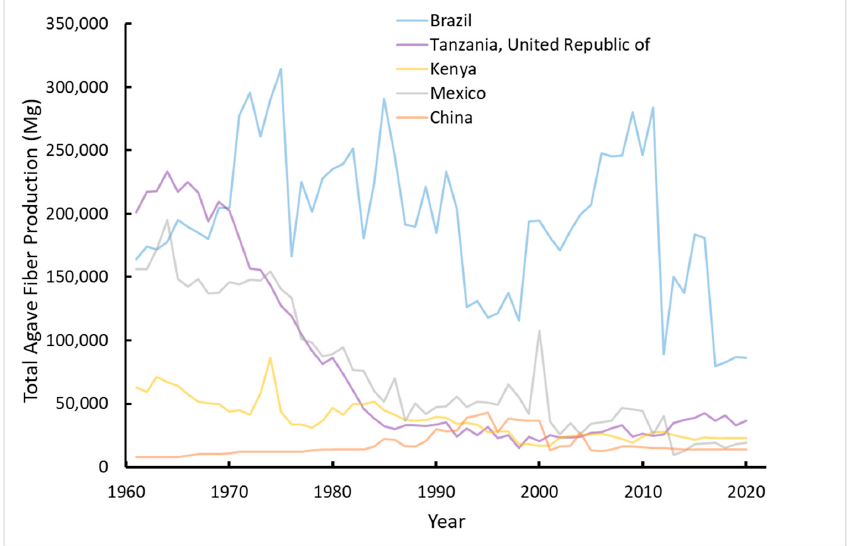
Figure 2. Production in Mg of fibers from four countries with the highest production over time and China, a recent top producer. Data source: FAOSTAT [31].